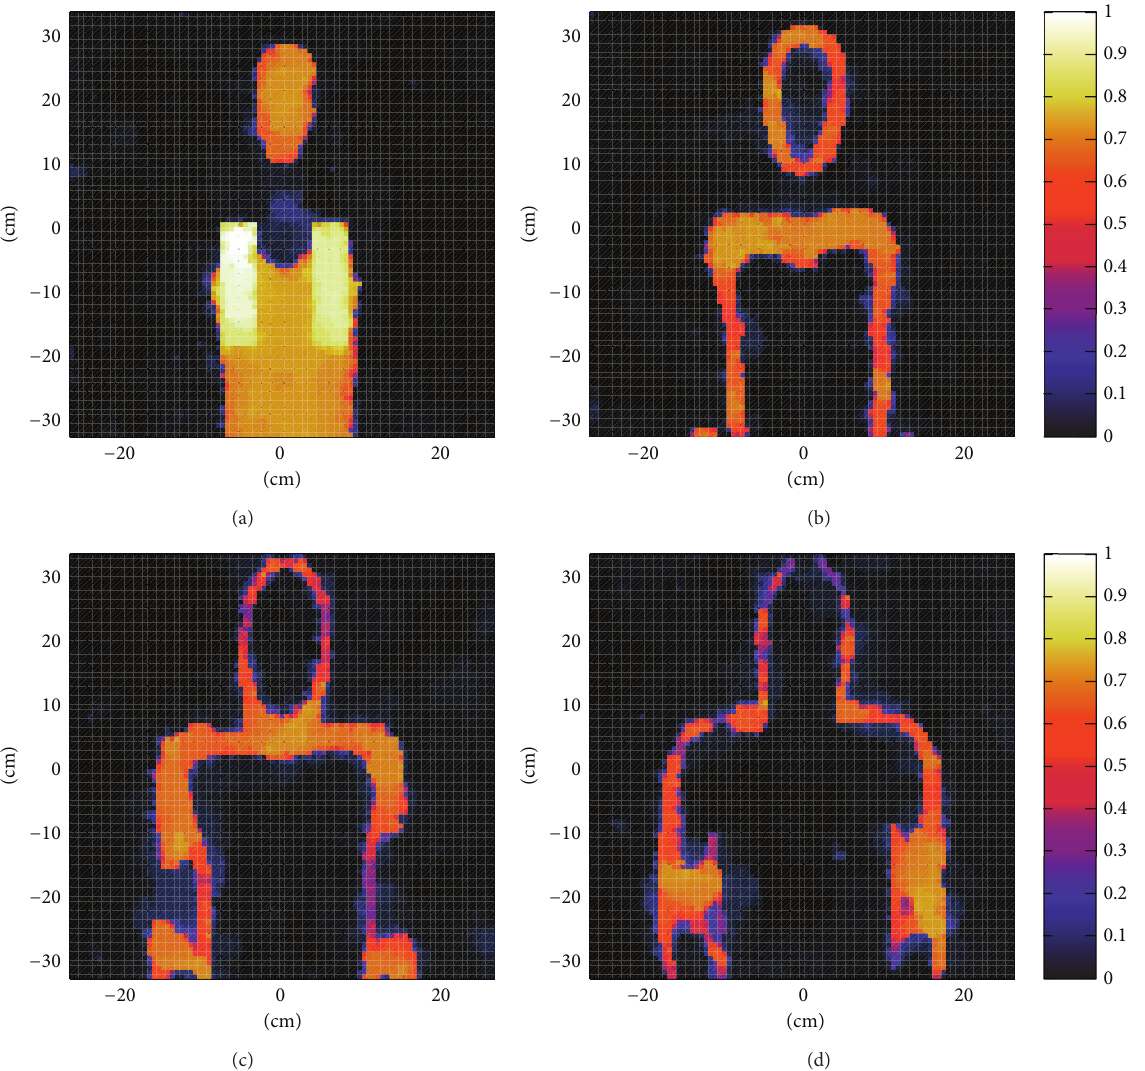
Figure 6: Reconstructed images of the person under test using CS methods at four different ranges: (a) 𝑥 0 + 0 mm, (b) 𝑥 0 + 30 mm, (c) + 60 mm, and (d) 𝑥 + 90 𝑥 0 0